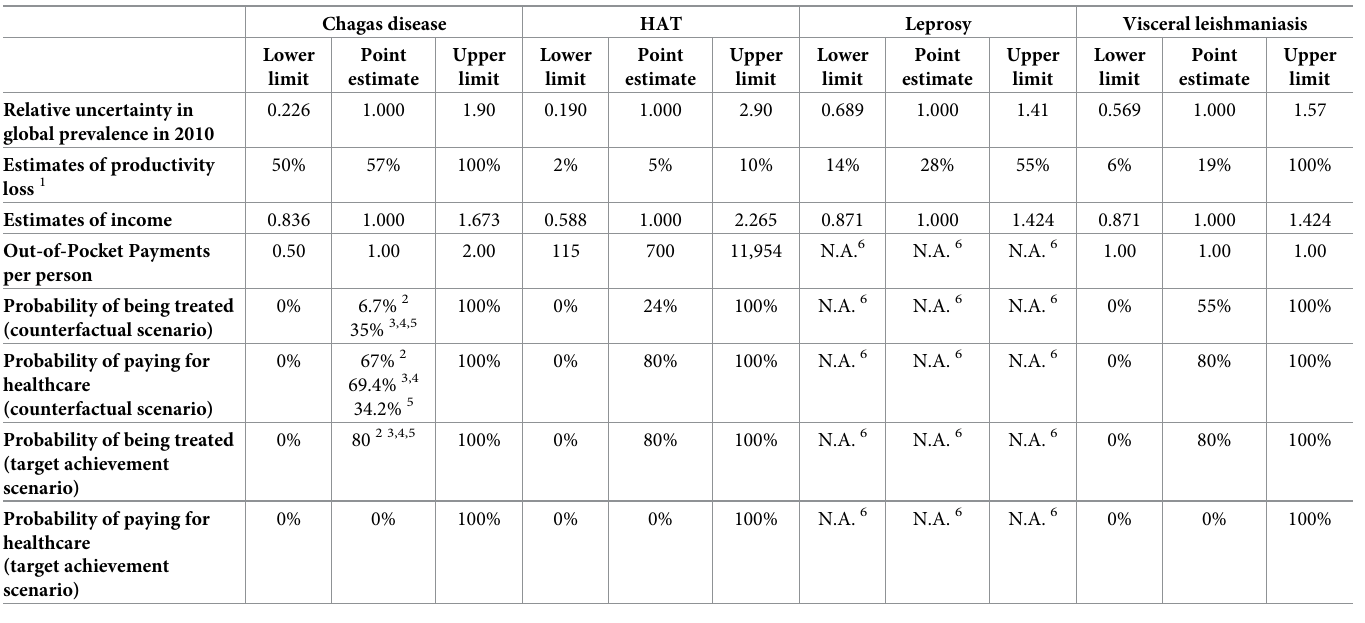
1. The productivity loss estimates seen in Table 1 are here shown as frequency-weighted estimates per disease with their respective upper and lower limits used in the sensitivity analysis 2. Value for acute Chagas disease sequela (weighted average of three most prevalent countries). 3. Value for chronic heart disease sequela (weighted average of three most prevalent countries). 4. Value for chronic digestive disease sequela (weighted average of three most prevalent countries). 5. Value for heart failure sequela (weighted average of three most prevalent countries).